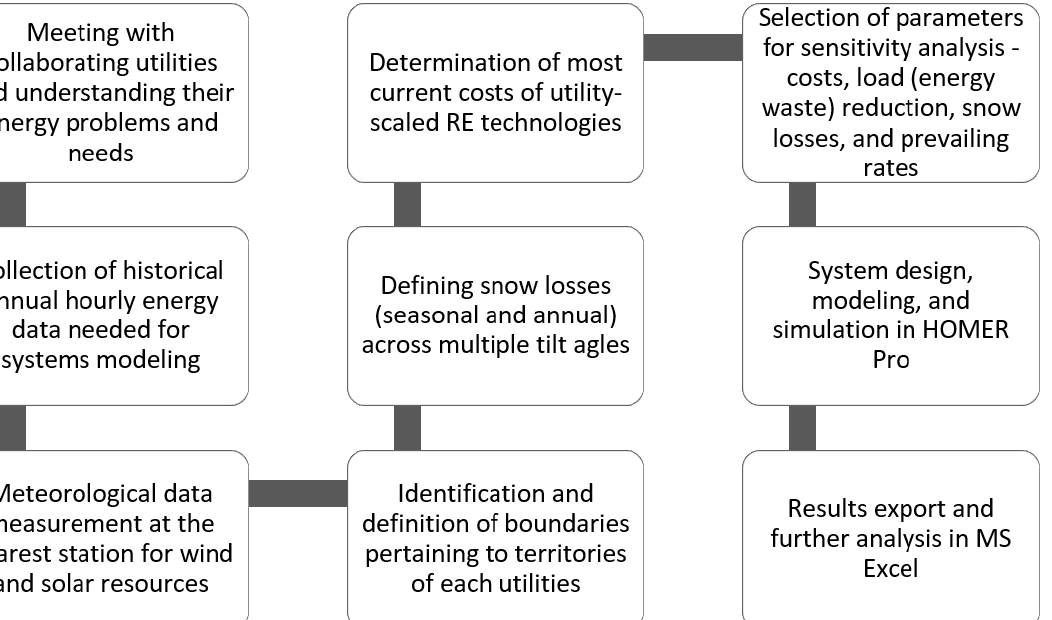
Figure 3. A system diagram for simulations with hydro represented as the grid.